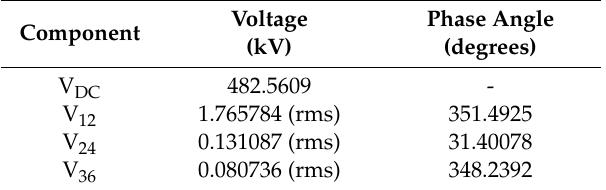
Table 2. DC and Dominant Voltage Harmonic Components at the Sending End of a 10 km Cable using CBM.